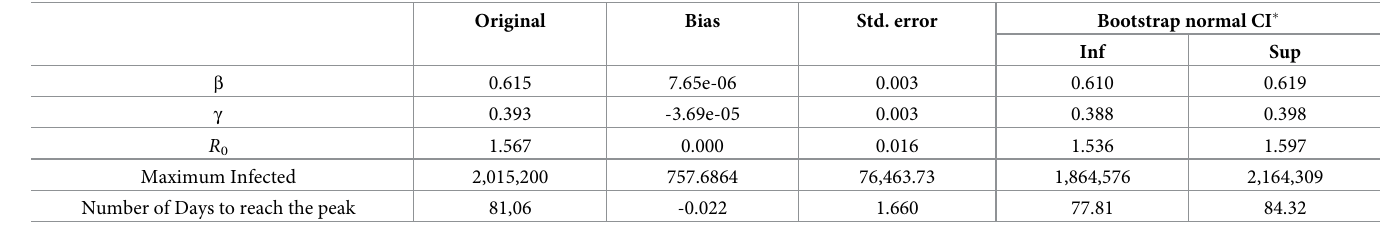
Table 1. Estimates